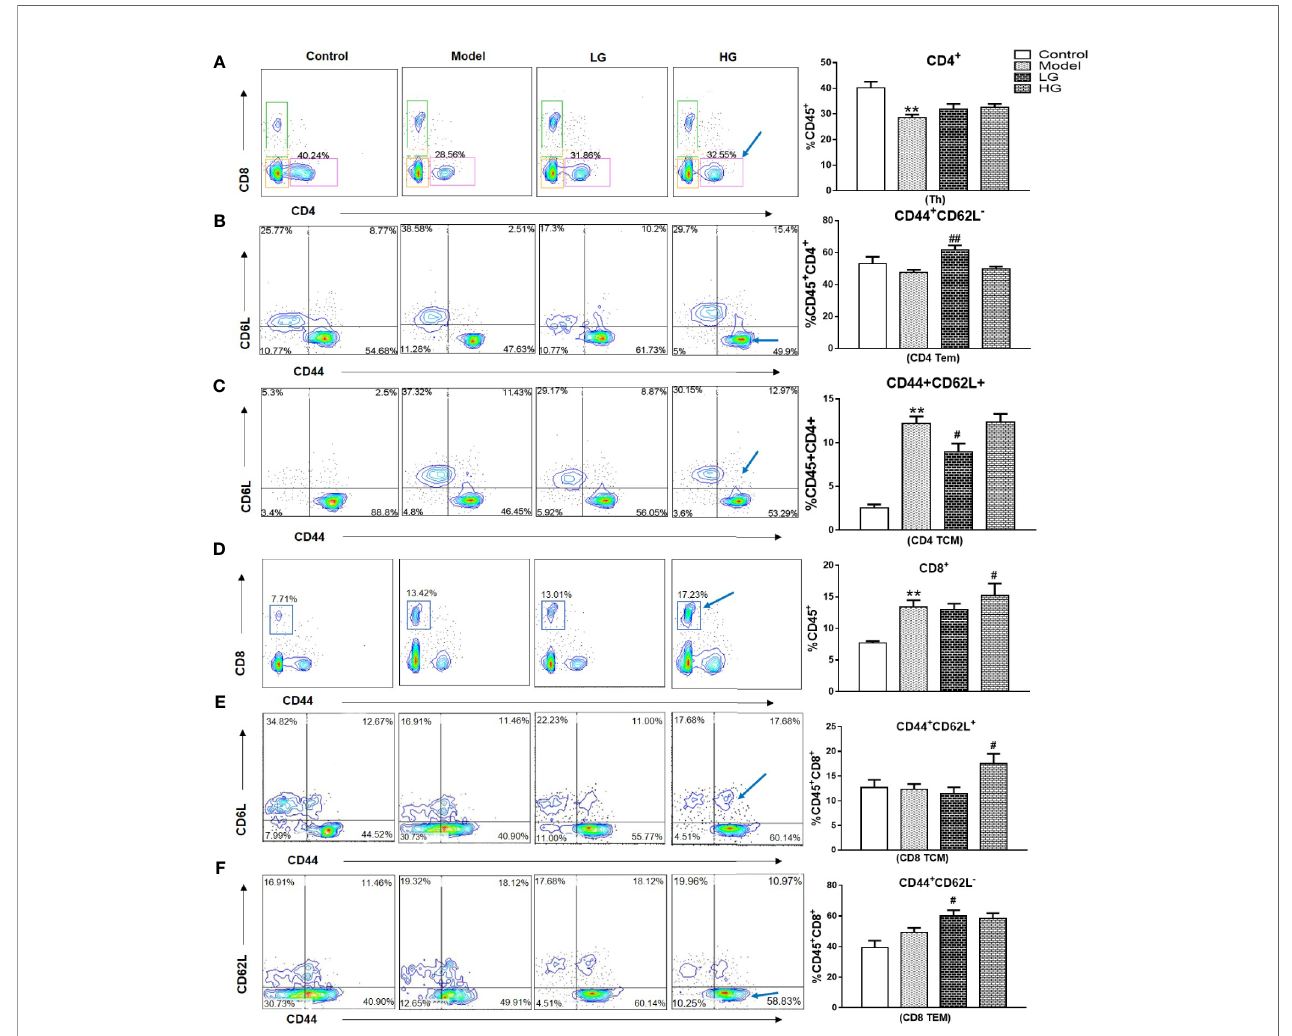
FIGURE 2 | Expression of CD4 + and CD8 + in immune microenvironment of hepatocellular carcinoma at 23 th weeks. (A) CD4 + level in the liver. (B) CD4 + Tem content in the liver. (C) CD4 + Tcm expression in the liver. (D) CD8 + level in the liver. (E) CD8 + Tcm level in the liver. (F) CD8 + Tem level in the liver. The CD4 + , CD4 + Tem, CD4 + Tcm, CD8 + , CD8 + Tcm, CD8 + Tem data in the liver cancer microenvironment were analyzed by ANOVA. The homogeneity test was fi rst performed, P > 0.05, the variances were uniform, and the LSD (L) test was used for multiple comparisons afterward, P < 0.05, the variances were not uniform. **p < 0.01 vs. control; # p < 0.05, ## p < 0.01 vs.